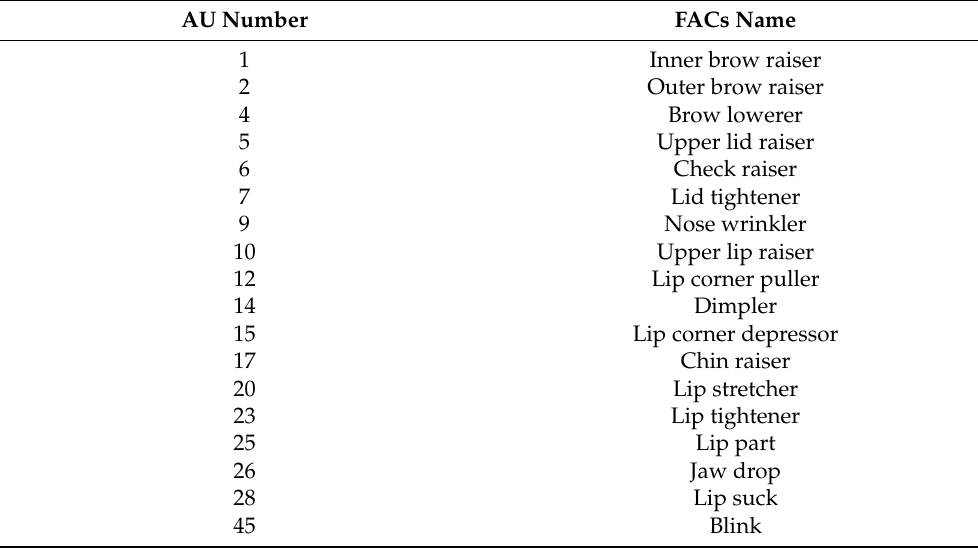
Table A1. Action Units extracted using the OpenFace library with its associated facial muscle movements of the facial action coding